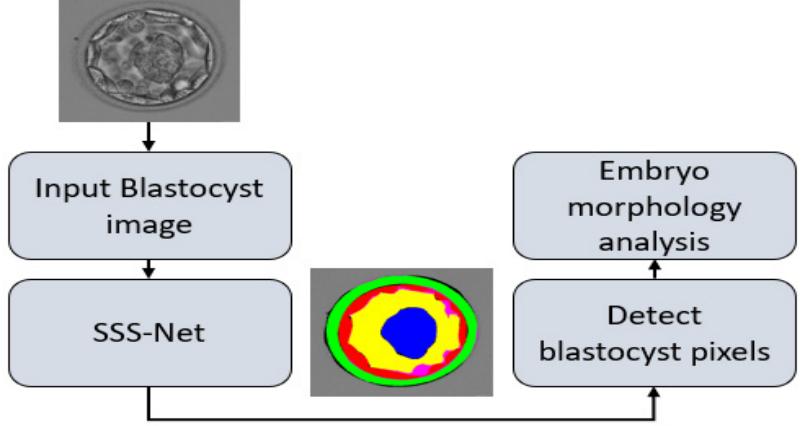
Figure 3. The overall workflow of the proposed method to detect blastocyst components for embryological analysis. Abbreviations: SSS-Net, sprint semantic segmentation network.